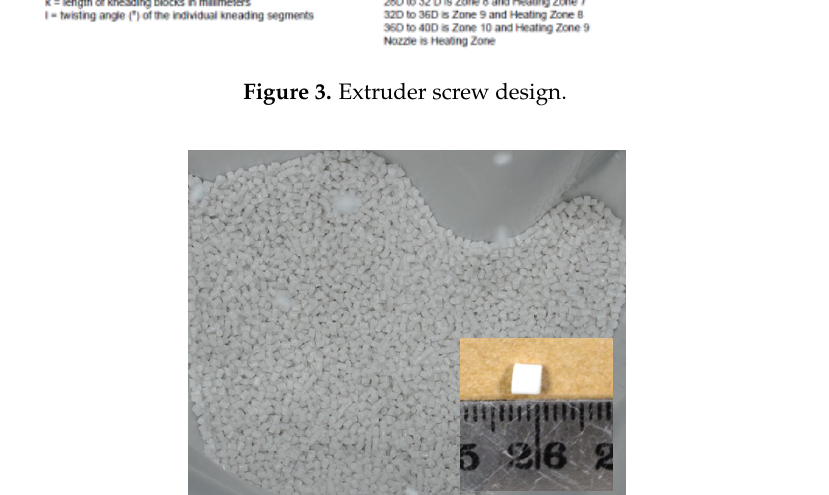
Figure 4. Final product of manufactured pellets. Table 1. Extrusion